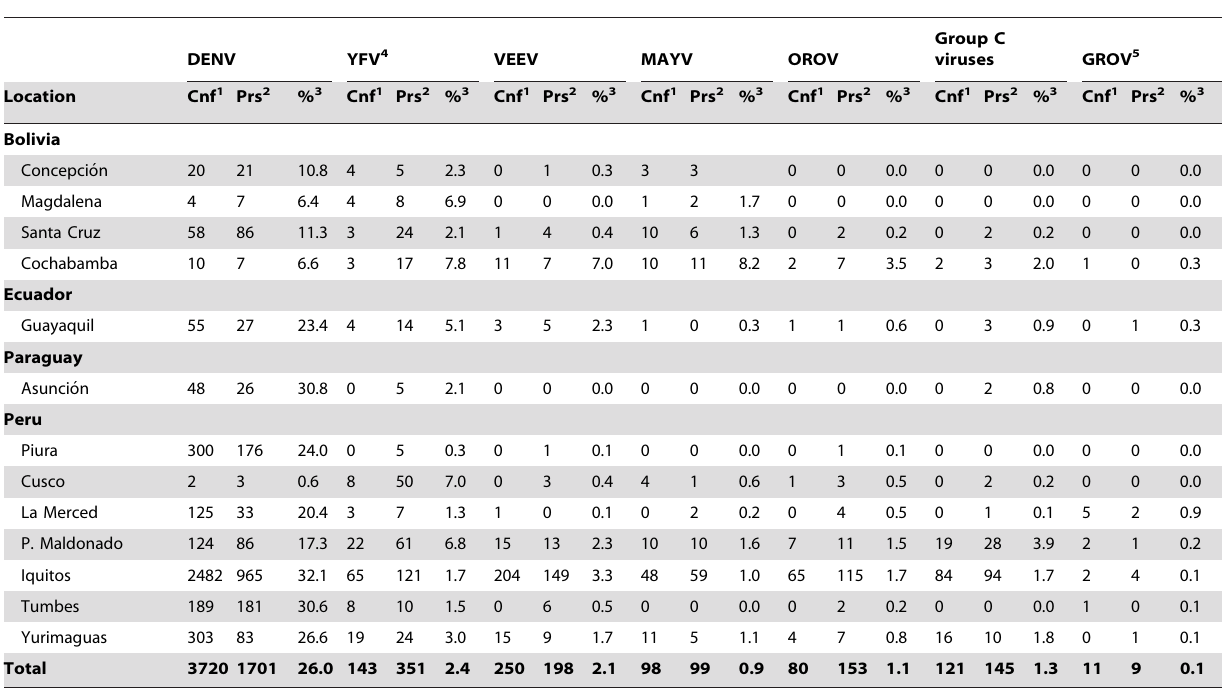
Table 5. Breakdown of arboviruses associated with febrile illness, by location, 2000–2007.